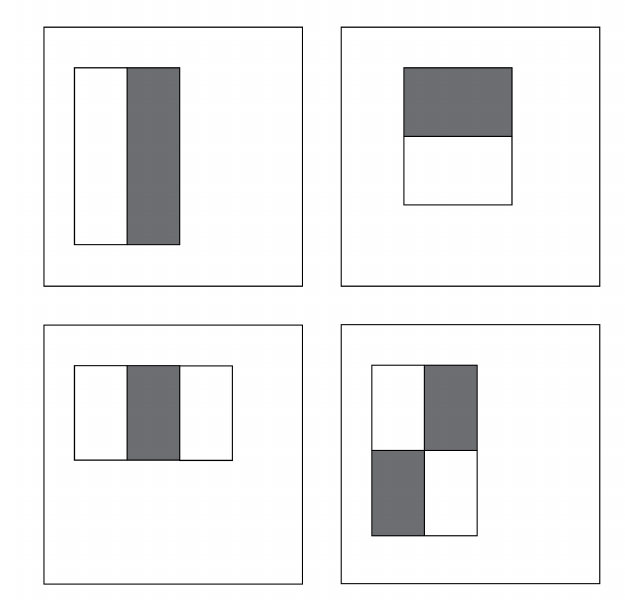
Figure 9. Integral image features used in boosting cascade face